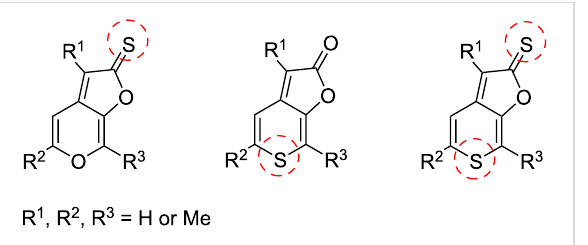
Figure 2: Target compounds with highlighted positions of oxygen to sulfur exchange.